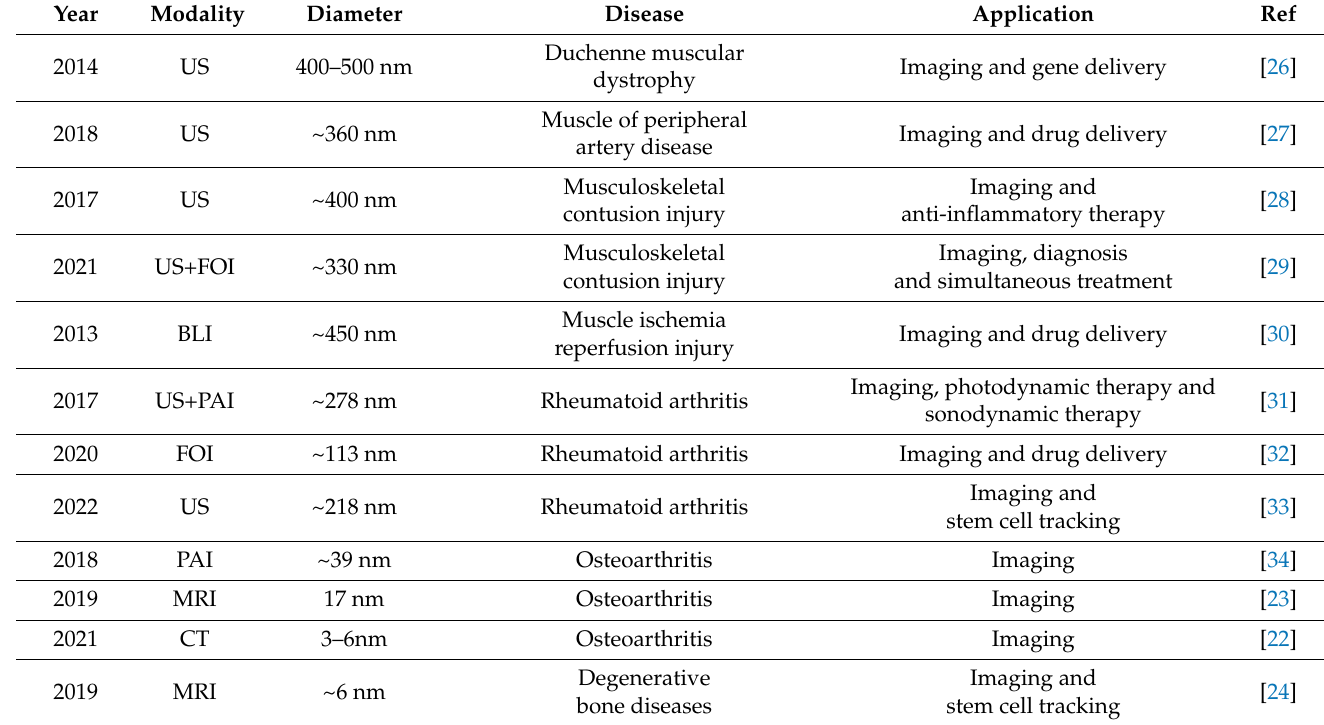
Table 1. A brief summary of the typical nanoscale contrast agents related to musculoskeletal system in the last